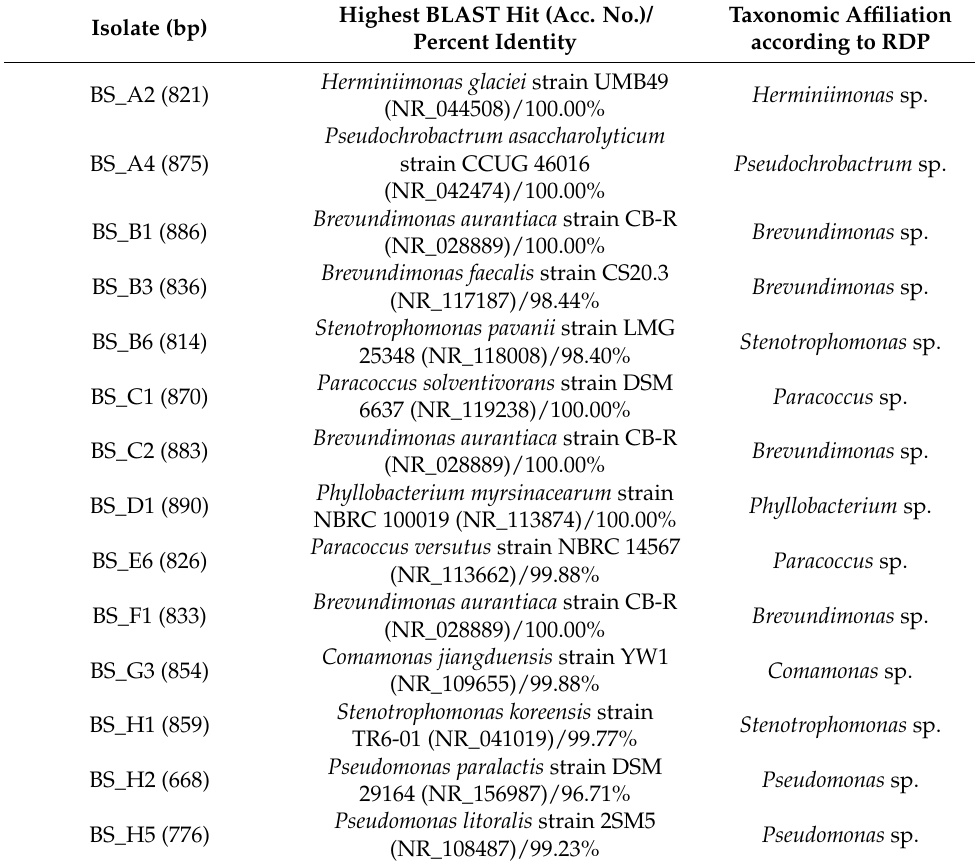
Table 2. Sequencing results of 16S rRNA genes of representative bacterial